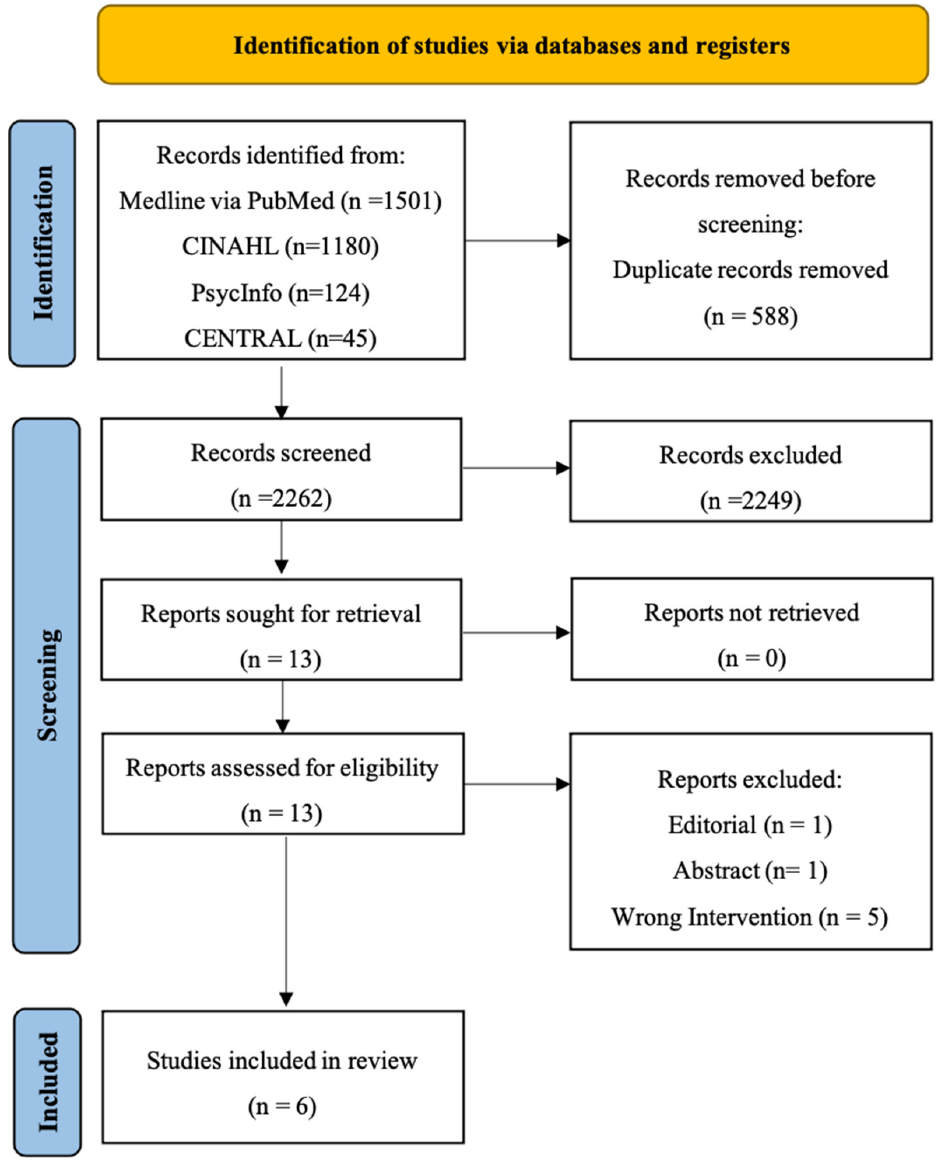
Figure 1. Preferred reporting items for systematic reviews and meta-analyses (PRISMA) diagram. Table 1. Characteristics of the studies on the effectiveness of nurse-led interventions to prevent mental health impairment in post-intensive care